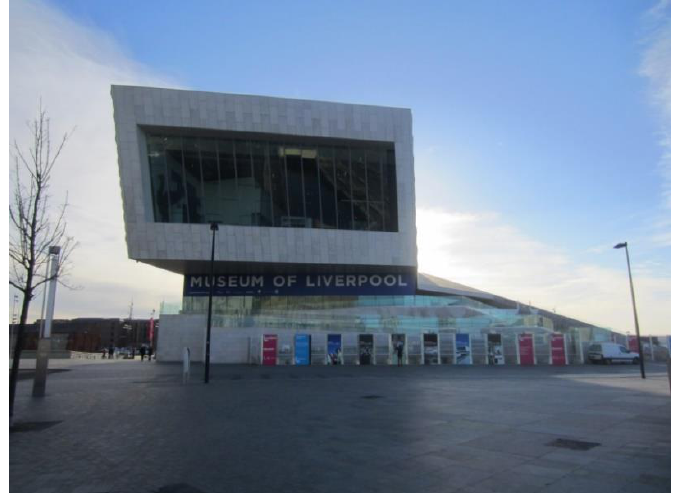
Figure 13. Example of museums promoting respect and social inclusion (P15) (Museum of Liverpool).